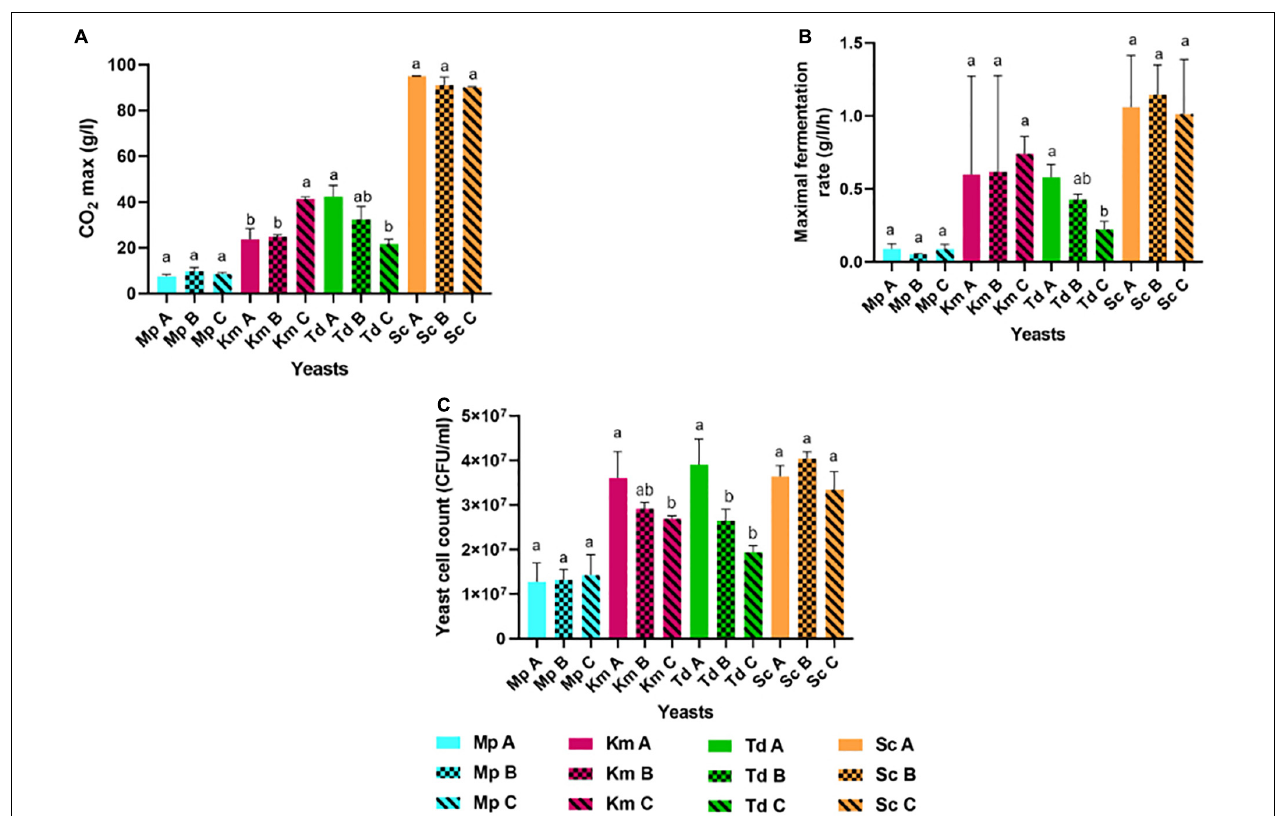
FIGURE 2 | Maximal carbon dioxide or CO 2 max production (A) , maximal fermentation rate (B) and yeast cell count (C) in M. pulcherrima , K. marxianus , T. delbrueckii and S. cerevisiae in Medium A, Medium B and Medium C. Blue bars- M. pulcherrima in Medium A (Mp A), B (Mp B) and C (Mp C). Pink bars— K. marxianus in Medium A (Km A), B (Km B) and C (Km C). Green bars— T. delbrueckii in Medium A (Td A), B (Td B) and C (Td C). Orange bars— S. cerevisiae in Medium A (Sc A), B (Sc B) and C (Sc C). Results obtained for treatments with the same letters are not statistically significant ( p < 0.05).